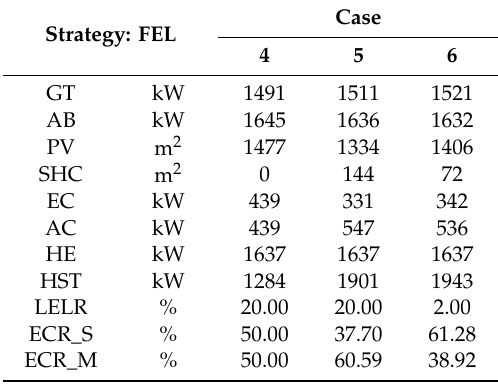
Table 6. Optimal design of uncertain cases in FEL.